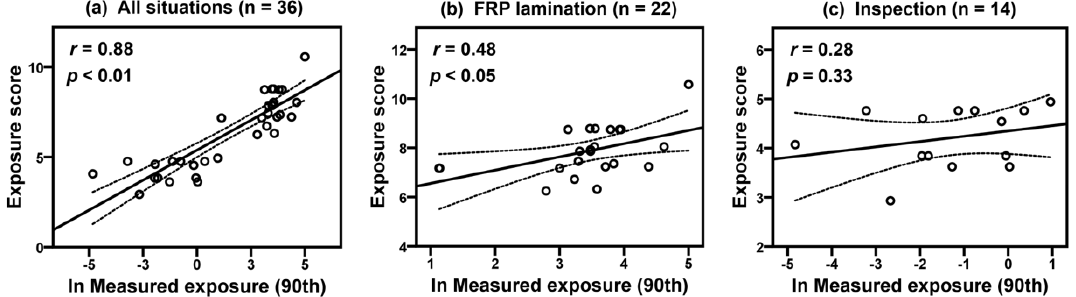
Figure 2. Scatterplots of exposure scores calculated using a new model and log-transformed exposure measurements (90th) for styrene collected on the FRP lamination and inspection tasks on situation level. The dashed lines indicate corresponding 95% CIs.